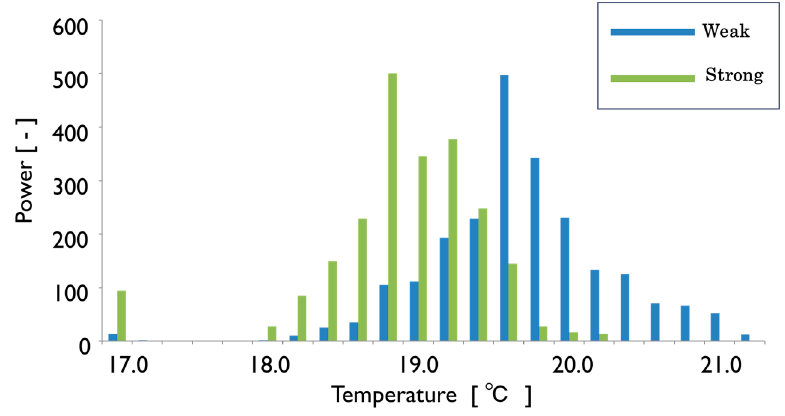
Figure 19. Comparison of temperature distribution between weak leaf and strong one.